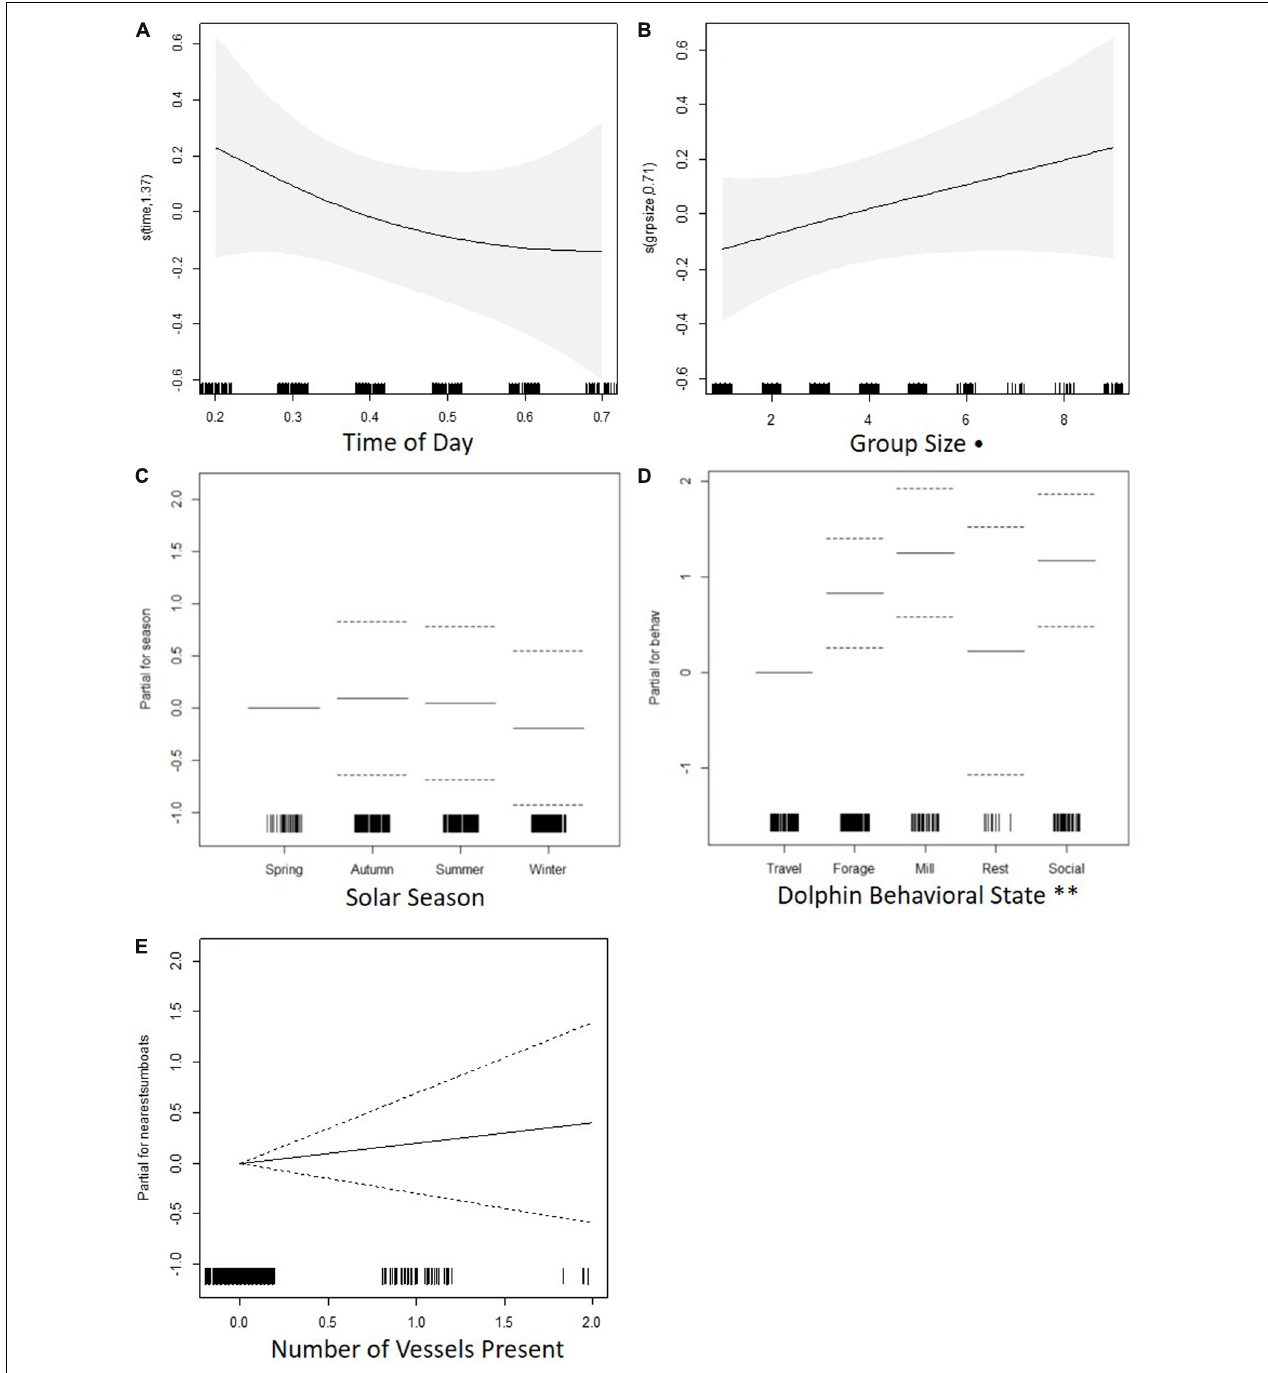
FIGURE 5 | Charts for the partial contribution of individual explanatory variables in the fitted GAM for reorientation rate. Charts include: (A) time of day, (B) dolphin group size, (C) solar season, (D) dolphin behavioral state, and (E) number of vessels present. The rugplot along the x -axis indicates the density of observations for each factor. On the y -axis, values > 0 indicate a positive correlation with reorientation rate, values < 0 indicate a negative correlation, and a value of 0 indicates no effect. Signif. codes: “**” 0.01; “ · ”